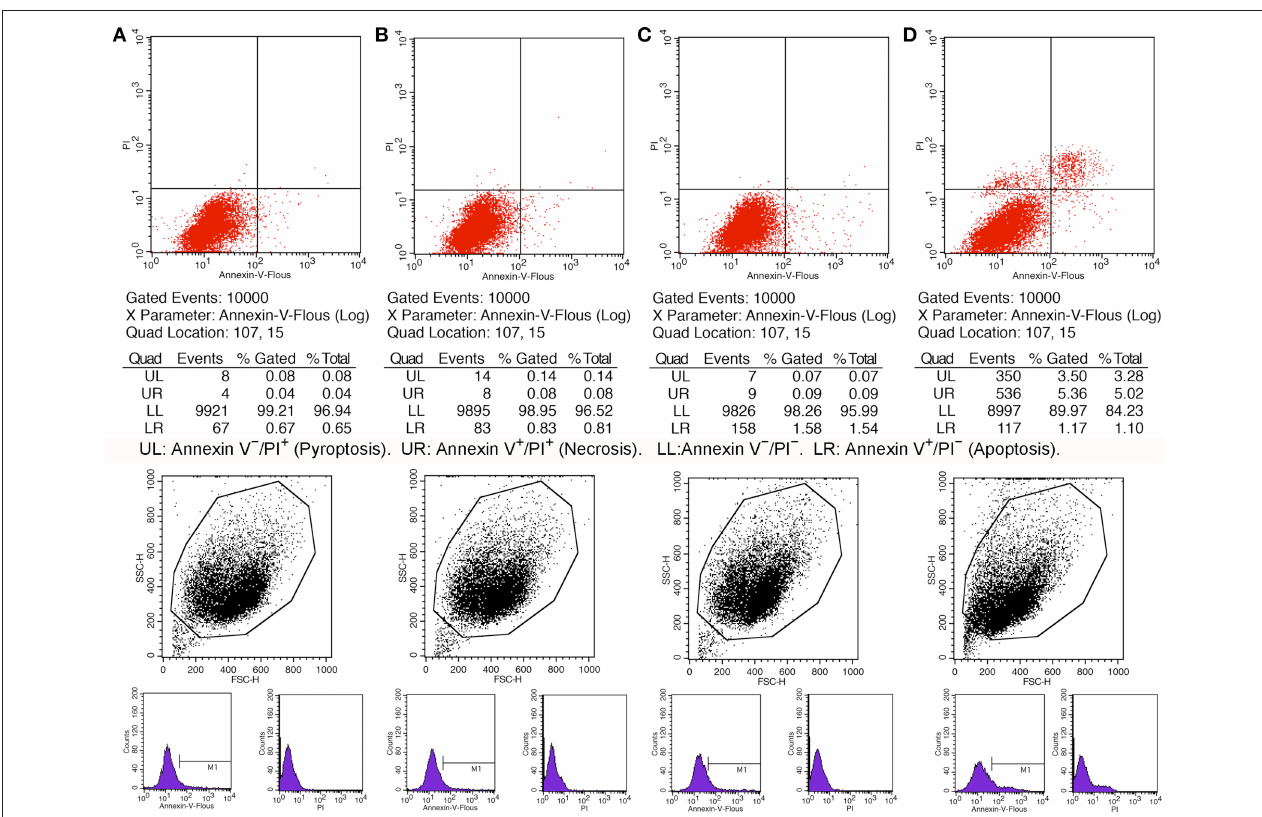
FIGURE 4 | Flow cytometry analyses of histone caused BMECs apoptosis, necrosis, and pyroptosis. BMECs were incubated with stimulated histone for 16h. Then, the BMECs were stained FLUOS-Annexin V/PI according to the manufacturer’s protocols and were examined by Flow cytometry. The results represent that Annexin V − /PI − (LL) and Annexin V − /PI + (Pyroptosis, UL), Annexin V + /PI − (Apoptosis, LR), and Annexin V + /PI + (Necrosis, UR). (A) Controls. (B) BMECs treated with histone (50 µ g/mL). (C) . BMECs treated with histone (100 µ g/mL). (D) BMECs treated with histone (200 µ g/mL). Histone caused BMECs necrosis (5.02%), pyroptosis (3.28%), and apoptosis (1.10%) in a dose-dependent. Three independent experiments were carried out by flow cytometry